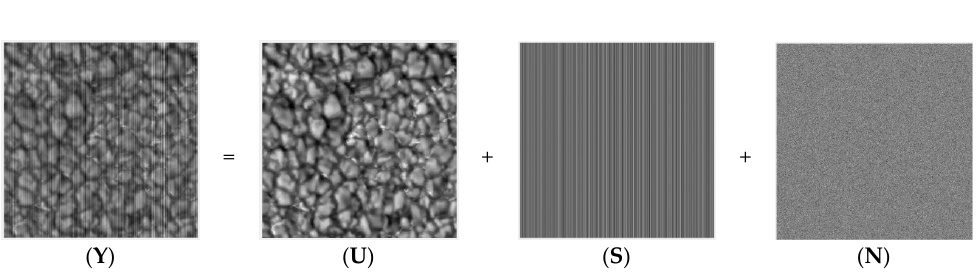
Figure 7. Noise image composition. ( Y ) noise image; ( U ) clear image; ( S ) column fixed pattern noise (CFPN); ( N ) random noise. (CFPN); ( N ) random Y = U + S + N. (2)